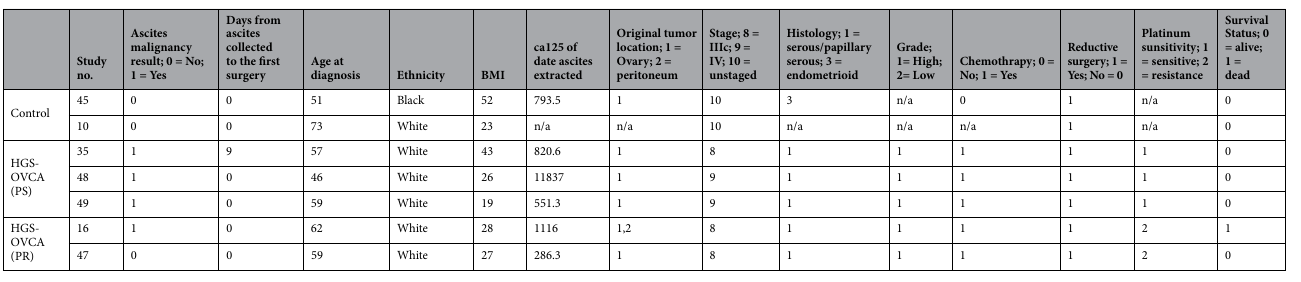
Table 2. Patient